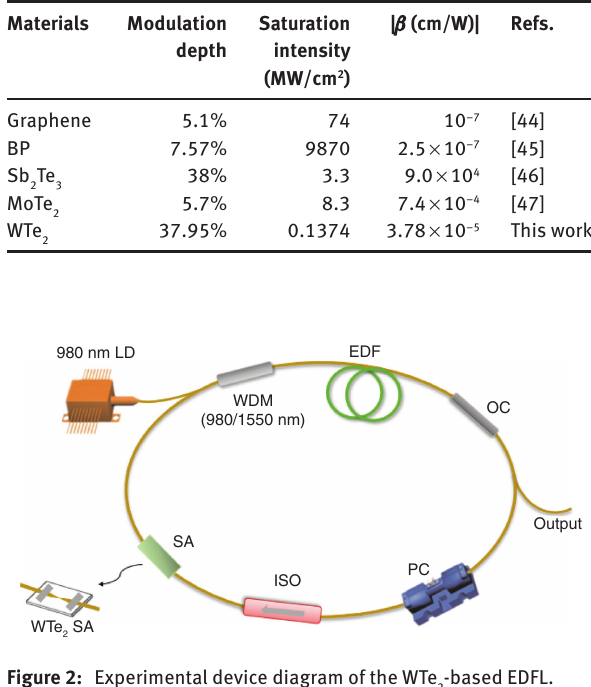
Figure 2: Experimental device diagram of the WTe